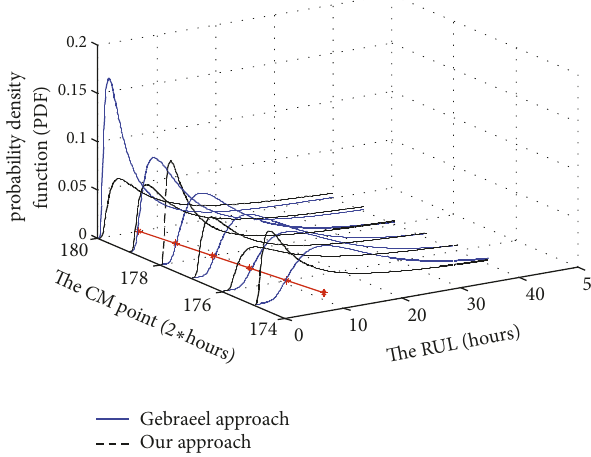
Figure 2: Illustration of the RUL distributions at last 6 CM points ( ∗ means actual RUL).